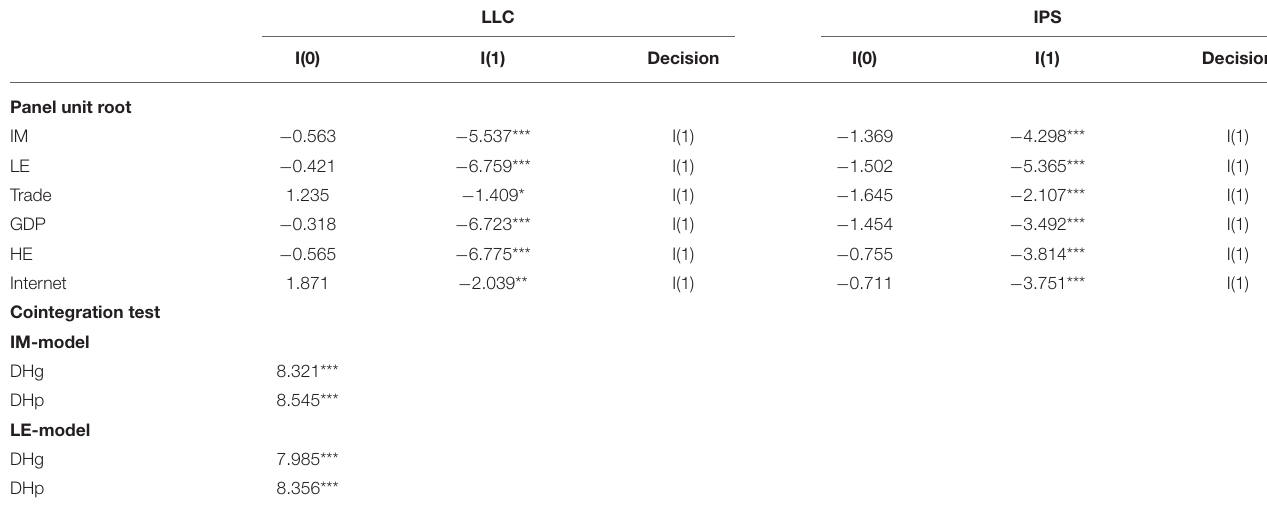
TABLE 3 | Panel unit root testing.